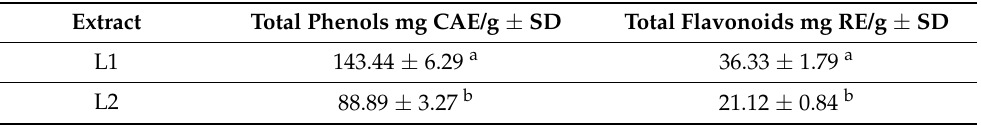
Table 2. Total phenol content and total flavonoids in L1: lyophilized balsam poplar buds extract 1% aqueous solution; and L2: aqueous balsam poplar buds